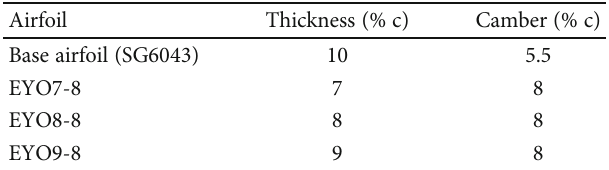
Table 1: Thickness and camber information for